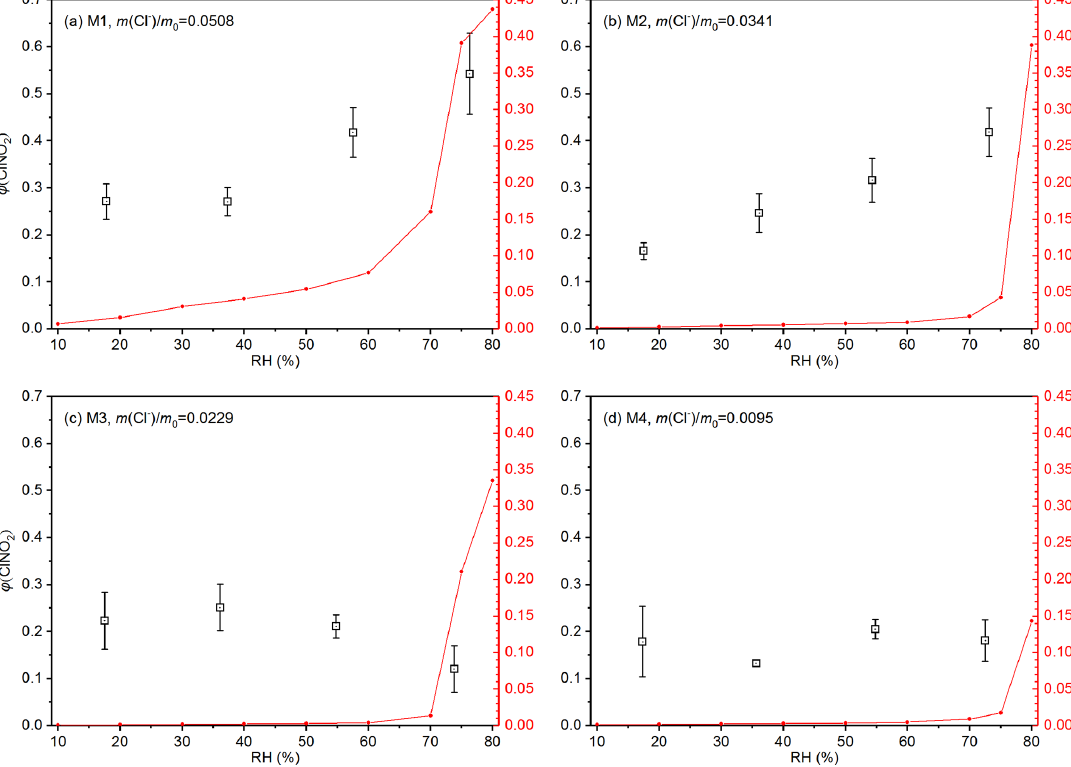
Figure 5. Measured ClNO 2 yields (black symbol) and m w /m 0 (red line) as a function of RH for (a) M1, (b) M2, (c) M3 and (d) M4. The error bar represents standard deviation, and m w /m 0 represents the normalized mass of particulate water (normalized to the mass of dry particles), which was measured as the relative increase in particle mass at a given RH compared to < 1%